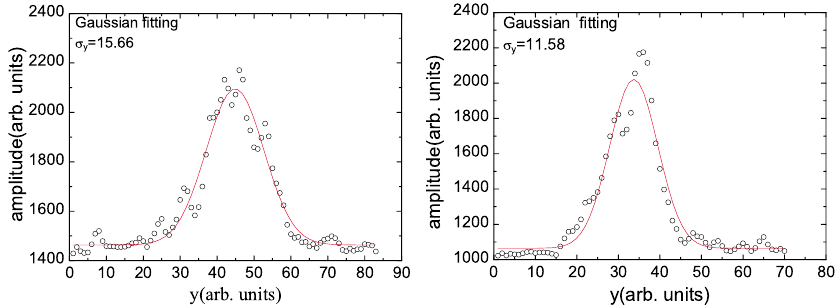
voltage.FIG. 6. (Color) The vertical bunch size observed with the streak camera as the solenoid off (left) and on (right).